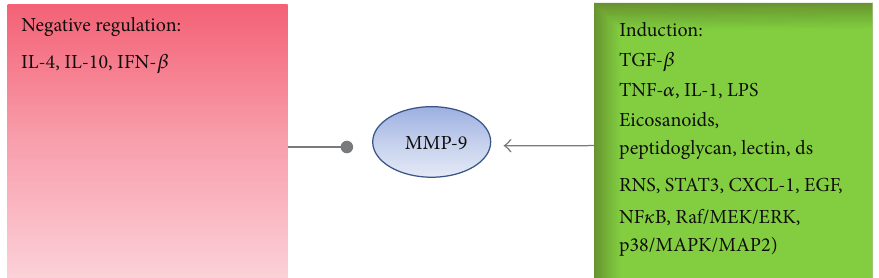
Figure 4: Regulation and induction of MMP-9: a variety of molecules are involved.